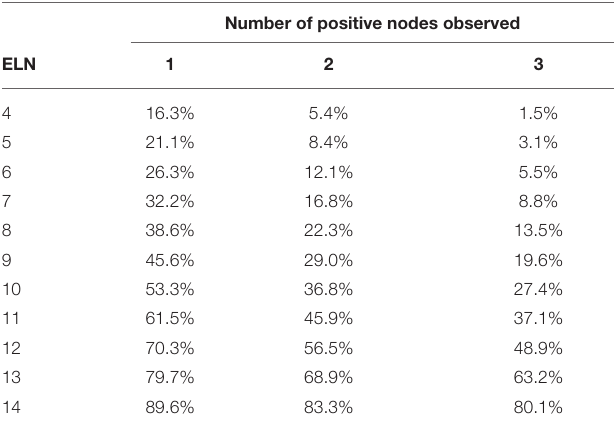
TABLE 1 | Lymph node status for different T stages. Variables